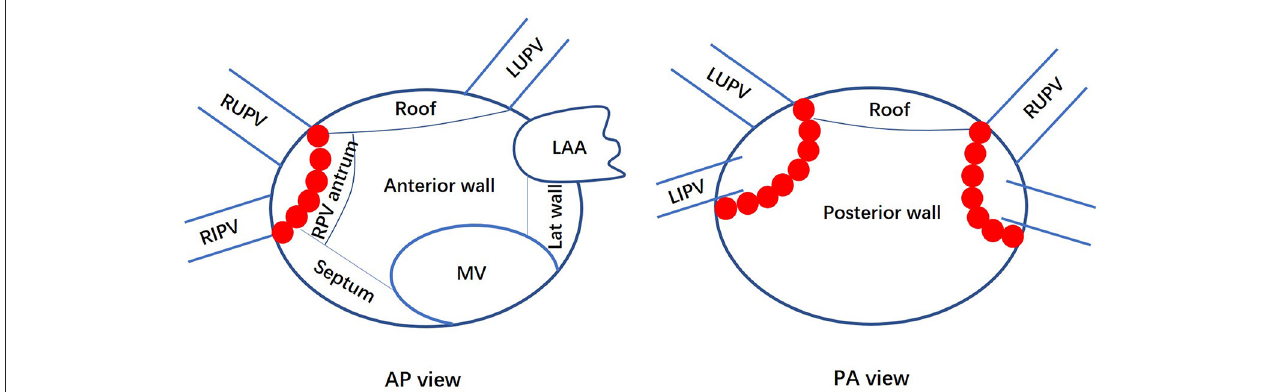
FIGURE 1 | Anatomic divisions of the left atrium. Anteroposterior (AP) and posterior-anterior (PA) views of the left atrium show how it was divided for the analysis of the low voltage area distribution. LA, left atrium; MV, mitral valve; LAA, left atrial appendage; Lat, lateral; PV, pulmonary vein; RS, right superior; RI, right inferior; LS, left superior; LI, left inferior; RPV, right pulmonary vein. Red dots represent ablation points on the pulmonary vein isolation line.